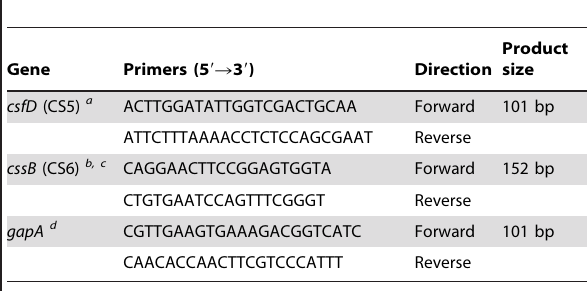
Table 2. Primers used for PCR and real-time